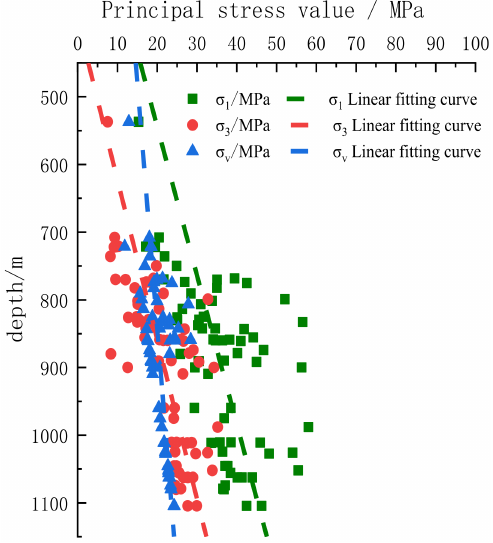
Figure 4. Fitting curve of principal stress with